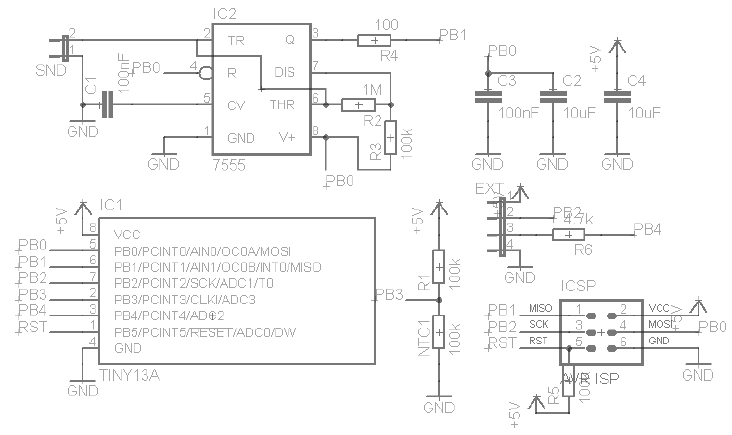
Figure 22. The probe with an integrated ATiny13a microcontroller.